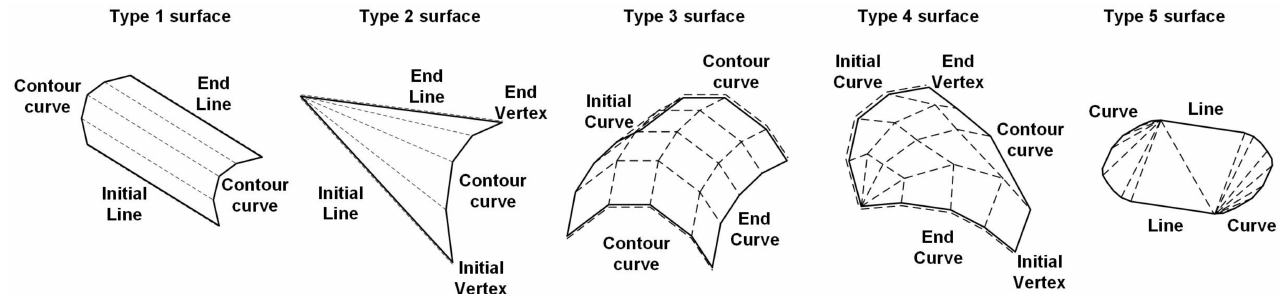
Figure 1. Types of surfaces supported by EVM.